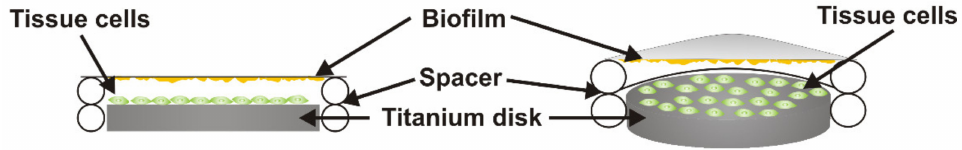
Figure 1. Schematic representation of the co-culture set up. Titanium disks were colonized by primary human gingival epithelial cells (HGEps) or fibroblasts (HGFs) (green). The S. oralis biofilm (yellow) was placed on top of spacers and was facing the tissue cell monolayers at a distance of 1 mm. The well was filled with an antibiotic-free cell culture medium. Left: 2D cross-section of the co-culture set up. Right: 3D representation with a cross-section of spacer and